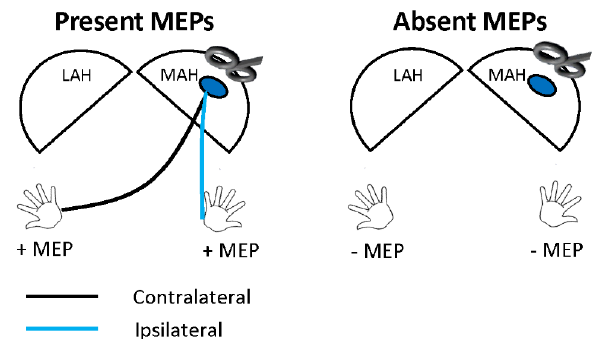
Figure 1. Example of transcranial magnetic stimulation assessment of motor evoked potentials (MEPs) from the more-a ff ected hemisphere (MAH). Presence of MEPs ( + MEP) was defined by presence of at least one MEP in either the contralateral (black line), ipsilateral (blue line), or both wrist flexors. MEP absence ( − MEP) was defined by lack of MEP presence in the wrist flexor of either arm.